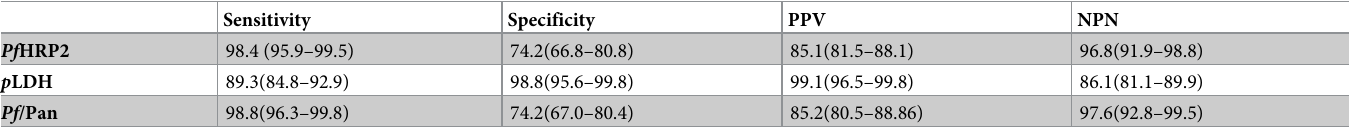
Table 3. Diagnostic accuracy of Pf HRP2, p LDH and P . f/Pan compared with expert microscopy (gold standard) for the diagnosis of Plasmodium falciparum malaria.